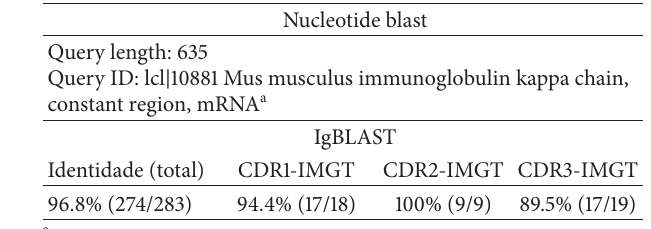
Table 3: Light chain homology analysis of displaying number 29 clone the three sequences with higher homology (GenBank).